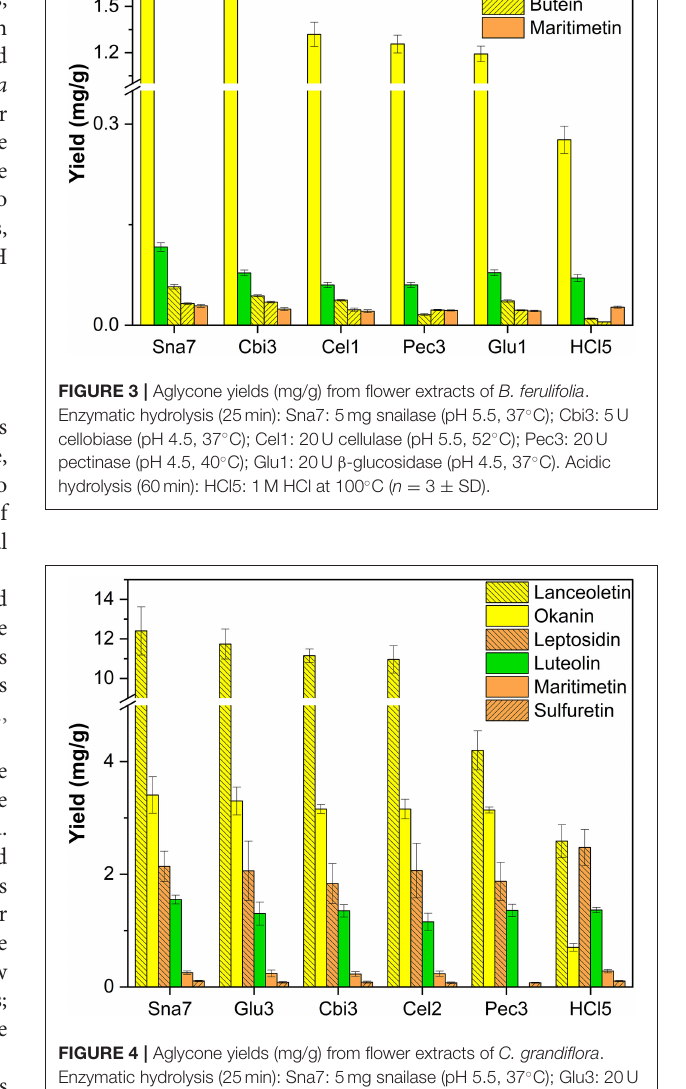
mg/g), leptosidin (1.8–2.5 mg/g), and sulfuretin